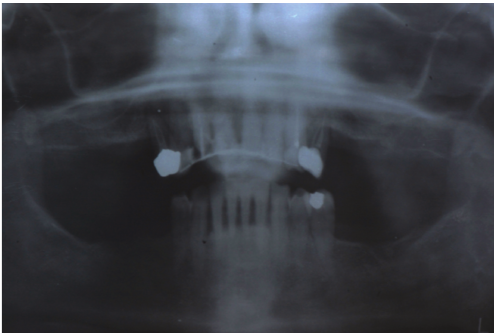
Figure 1: Preoperative panoramic